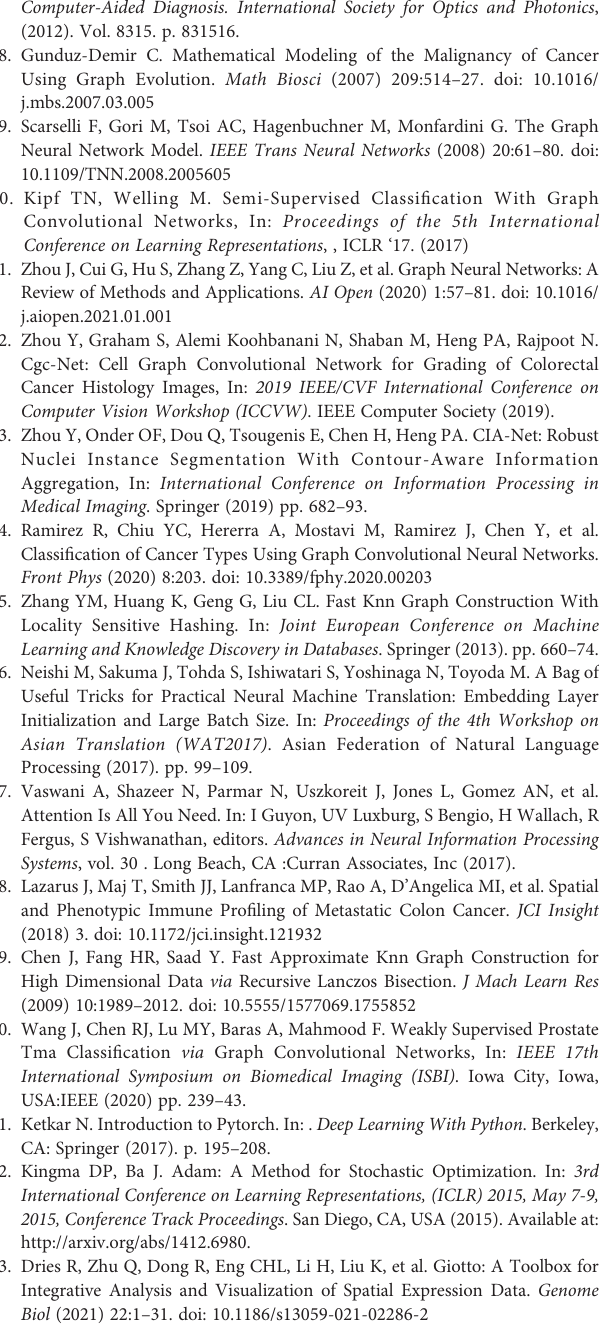
Figure 1. Clin Cancer Res (2011) 17:635 – 7. doi: 10.1158/1078-0432.ccr-